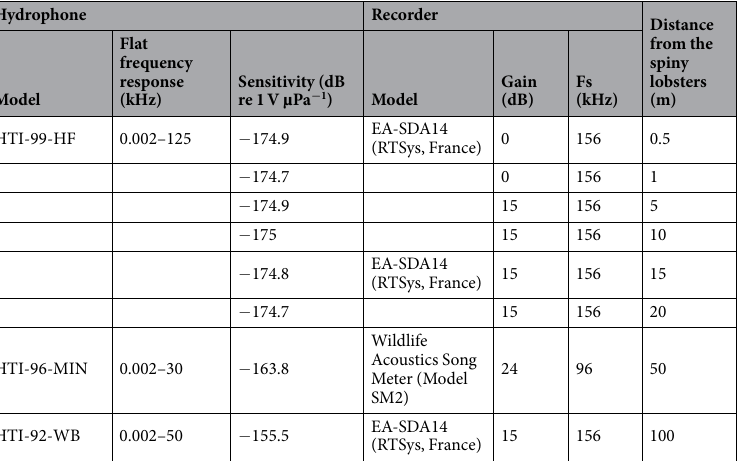
Table 2. Characteristics of the recording devices used for the linear array of hydrophones (placed between 0.5 and 100 m from the spiny lobsters) during in situ recordings. Fs: frequency